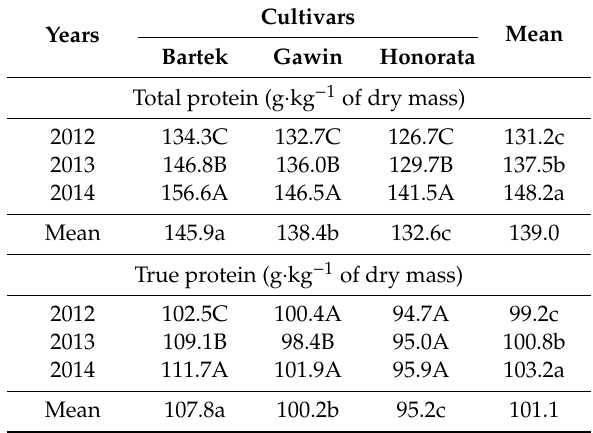
Table 7. Total and true protein content in tubers of potato tubers in study years of dry